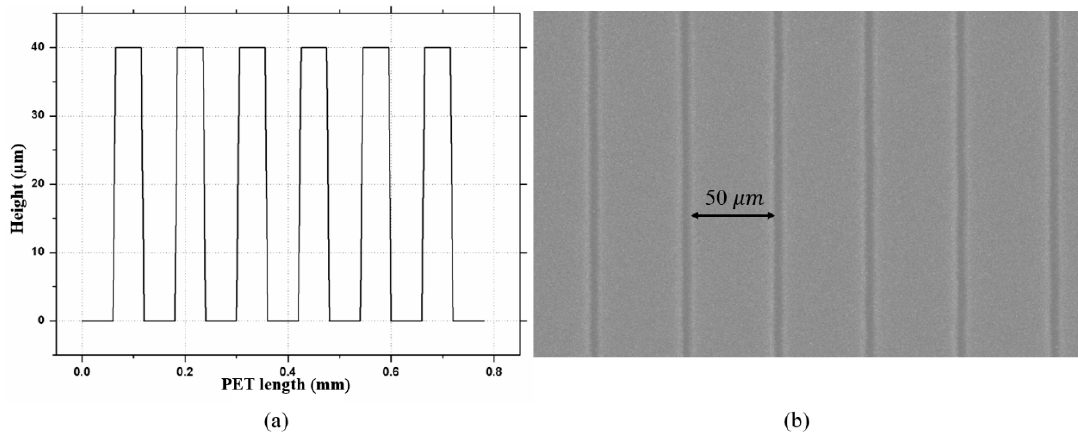
Figure 13. Experimental results: ( a ) amplifications of the sample profile of the experiment; ( b ) SEM image of bubble-free imprinting at a PET web speed of 24.2 mm/s.